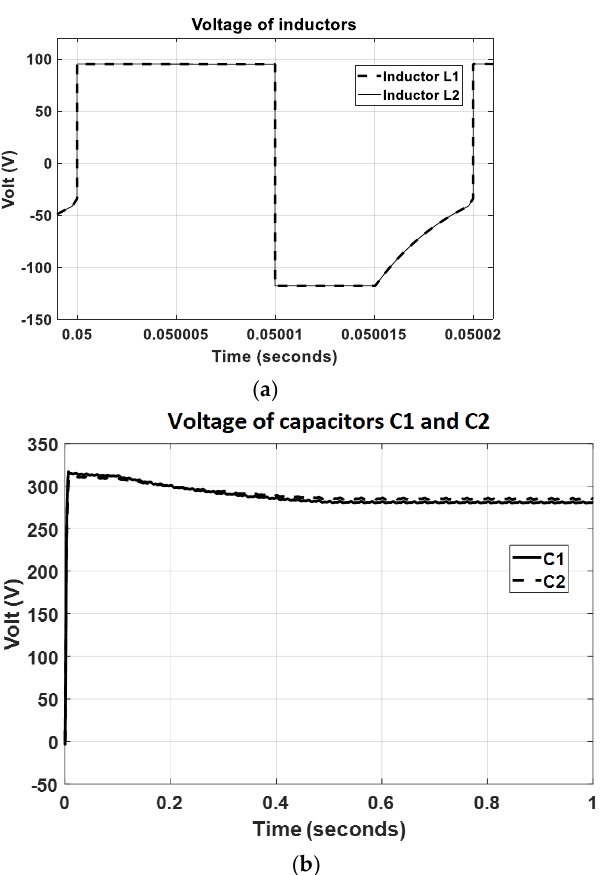
Figure 18. Voltage waveforms across inductors 𝐿 1 − 𝐿 2 ( a ) and capacitors 𝐶 1 − 𝐶 2 ( b ) in the proposed boost converter.